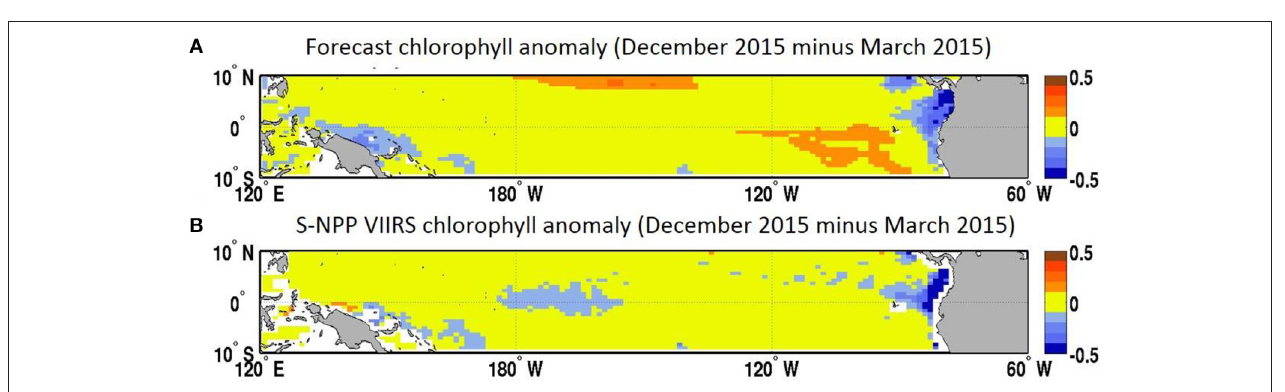
FIGURE 7 | (A) Chlorophyll concentration anomaly (December 2015 minus March 2015, µ g chl L − 1 ) from the March 2015 forecast for December 2015 and (B) chlorophyll concentration from S-NPP VIIRS ( µ g chl L − 1